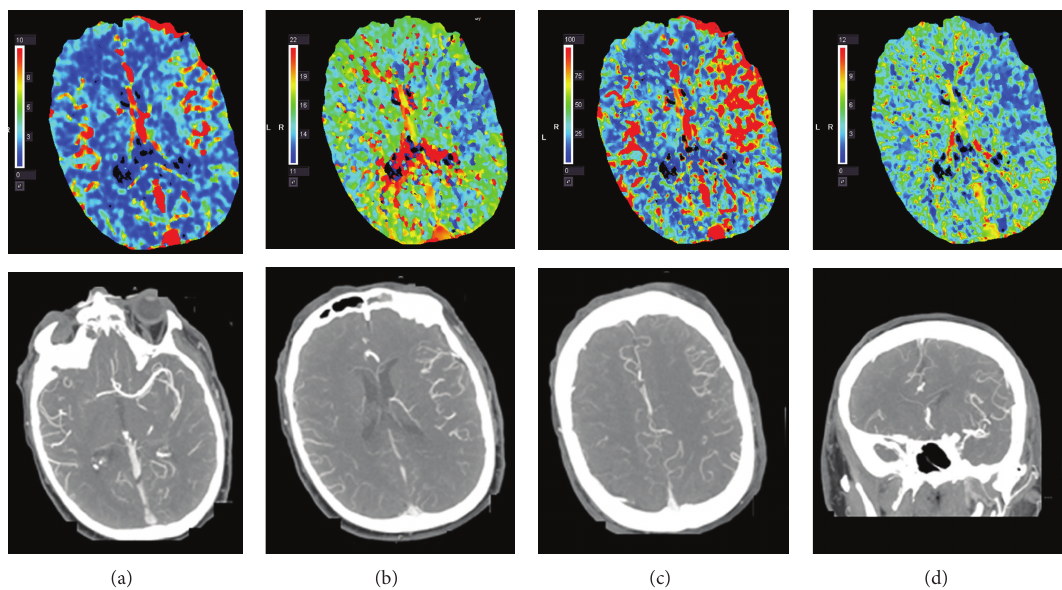
Figure 1: Hyperperfusion on computed tomography perfusion and the dilation of the left middle cerebral artery and its branches on CT angiogram after iv tPA treatment: (a) increased cerebral blood volume; (b) shortened time to peak; (c) increased cerebral blood flow; (d) shortened mean transit